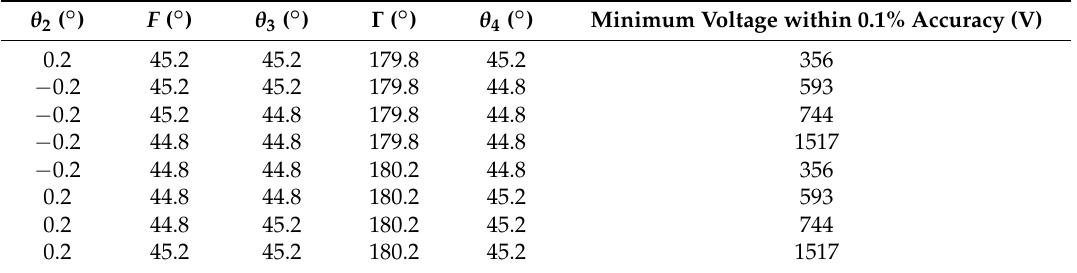
Table 1. Simulation results about the angle-axis compensation method of angle errors.